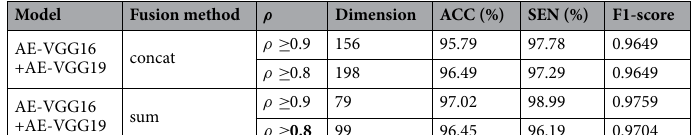
Table 7. Experimental results of direct feature fusion. Significant values are in bold.